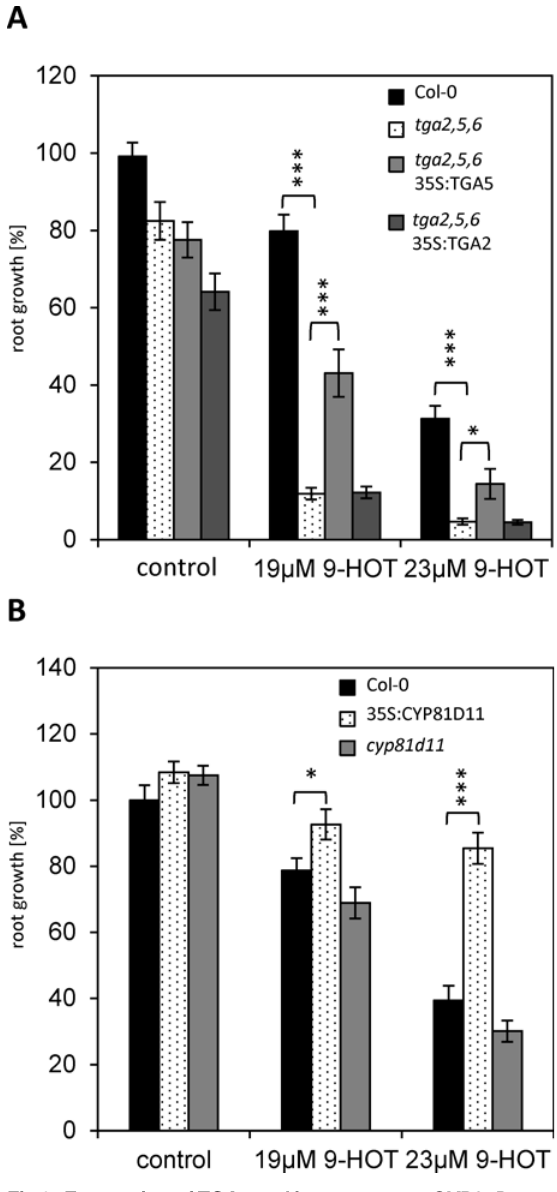
Fig 2. Expression of TGA5 and its target gene CYP81D11 are mediating tolerance to 9-HOT. Root growth of several Arabidopsis transgenic lines has been quantified comparing 9-HOT treated and untreated roots. The untreated wt (Col-0) is set to 100%. Results obtained from the Arabidopsis triple TGA mutant tga2 , 5 , 6 and lines expressing TGA5 or TGA2 under control of the 35S promoter in the tga2 , 5 , 6 background (A) or 35S:CYP81D11 and cyp81d11 (B) are shown. Given are mean values +SE (n (cid:1) 22). The indicated statistical differences are calculated using the student ’ s t -test: * p (cid:3) 0.05, ** p (cid:3) 0.01, *** p (cid:3)